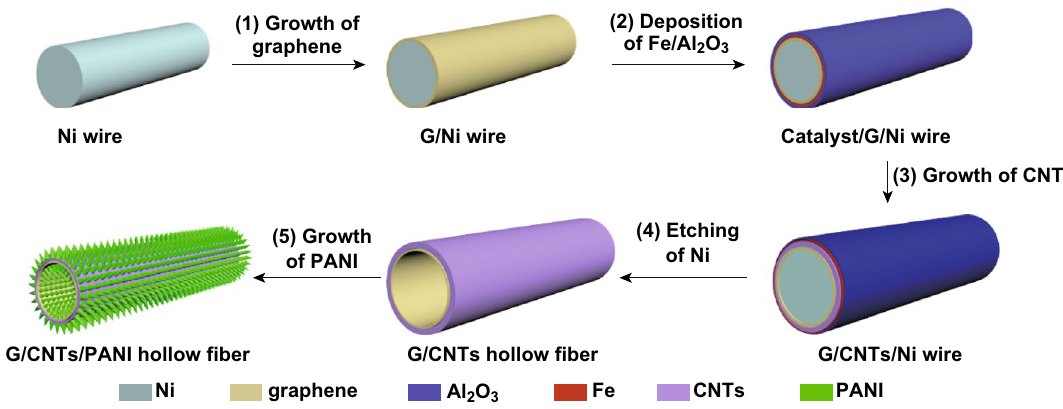
Fig. 1 Schematic of the fabrication process of self-supported G/CNTs hollow fiber and its